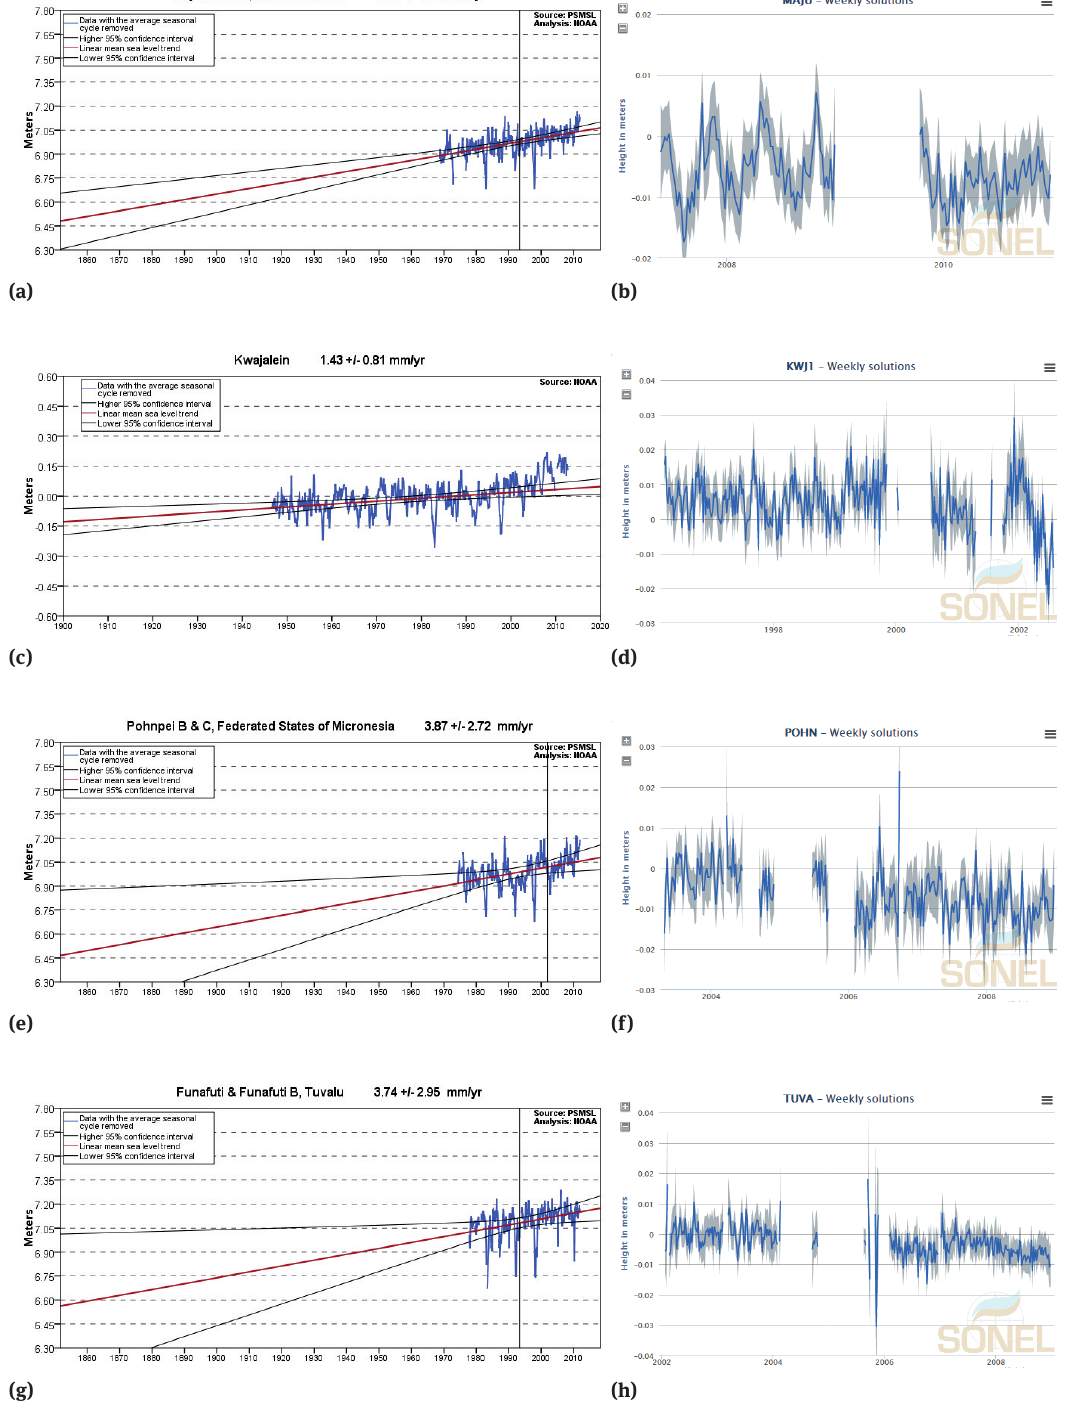
Fig. 3. Rate of rise of sea level (from [23]) and vertical height of closest GPS station (from [25]) in Western South Pacific island locations. The GPS data are scattered data only helpful to detect the presence or absence of a general subsidy for the area of the tide gauge. No conclu- sive statement can be made about the vertical stability of the tide gauge from these data. The reading of the tide gauge may also be biased upwards or downwards by other factors additional to subsidence or